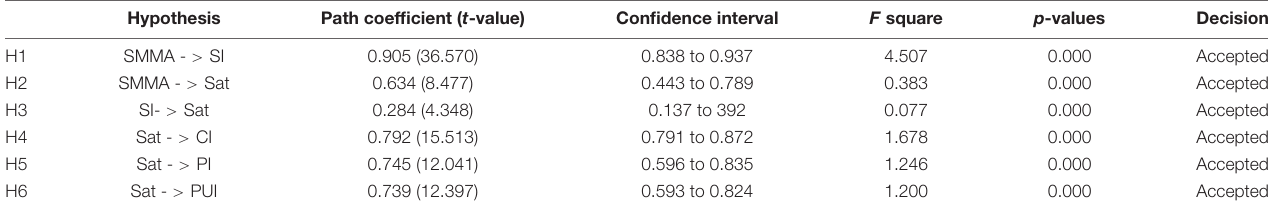
FIGURE 3 | Structural model. TABLE 5 | Hypothesis